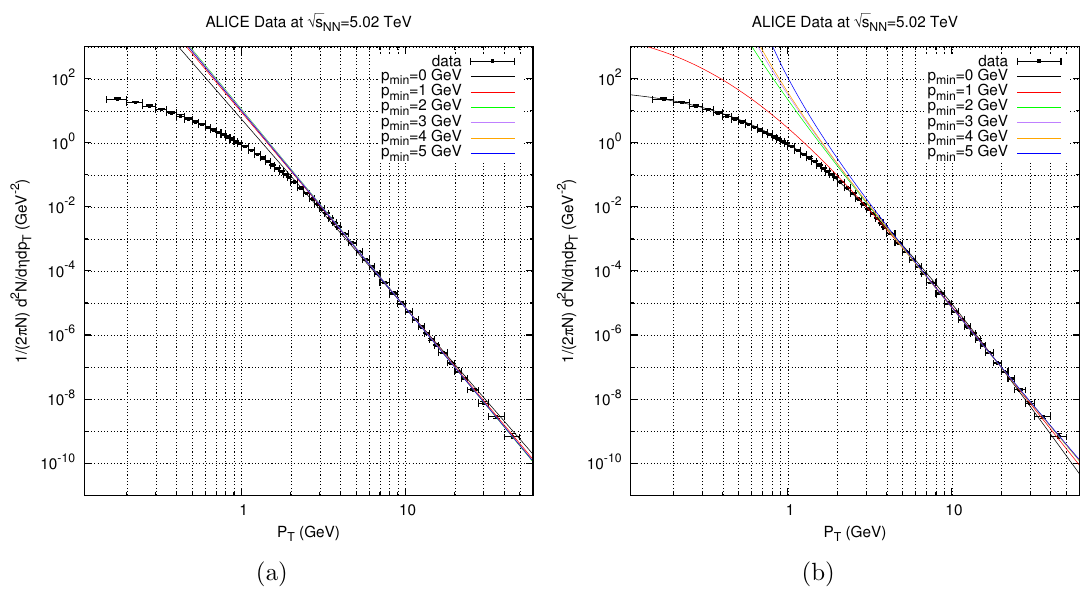
Figure 13. Fit of the two parameter ansatz in eq. (E.2) (left) and the three parameter ansatz in eq. (E.3) to the ALICE dataset at p s = 5 : 02 TeV in the data cuto(cid:11)s.